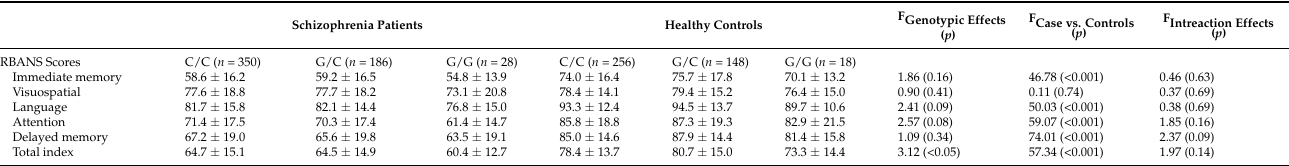
Table 1. Genotypic effects on cognitive functions between schizophrenia patients and HCs.